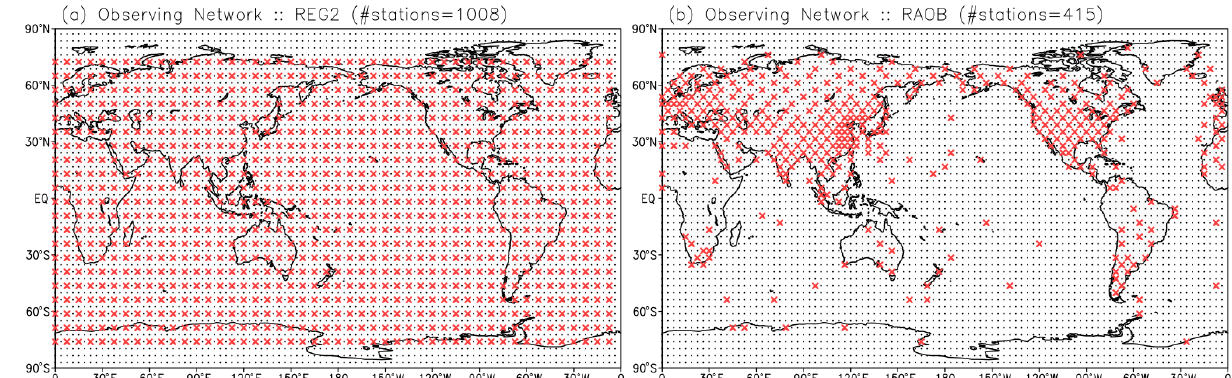
Figure 4. Observing networks for (a) REG2 and (c) RAOB experiments. Small black dots and red crosses represent model grid points and observing points,